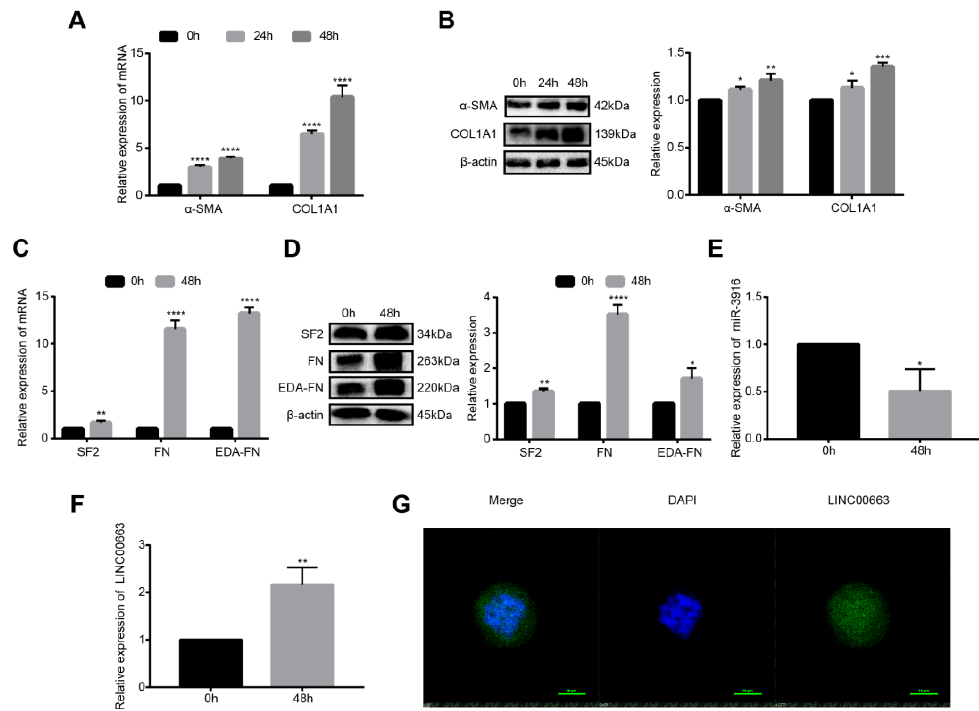
Figure 2. Validation of ceRNA network in activated LX-2 cells. Relative expression of α -SMA and COL1A1 in LX-2 cells treated with 10 ng/mL TGF- β for 24 h or 48 h detected by ( A ) RT-qPCR and ( B ) WB. Relative expression of SF2, FN and EDA-FN in LX-2 cells treated with 10 ng/mL TGF- β 1 for 48 h detected by ( C ) RT-qPCR and ( D ) WB. ( E ) Hsa-miR-3916 was downregulated in activated LX-2 cells. ( F ) LINC00663 was upregulated in activated LX-2 cells. ( G ) RNA FISH was performed to determine the location of endogenous LINC00663 (green) in LX-2 cells. Nuclei were counterstained with DAPI (blue). Scale bar = 10 µ m. * p < 0.05, ** p < 0.01, *** p < 0.001, **** p < 0.0001. Each experiment was repeated three times and similar results were obtained. ceRNA, competing endogenous RNA; COL1A1, collagen type I alpha 1 chain; EDA-FN, extra domain A of fibronectin; FISH, fluorescence in situ hybridization; FN, fibronectin; HSCs, hepatic stellate cells; RT-qPCR, real-time quantitative PCR; α -SMA, α -smooth muscle actin; SF2, splicing factor 2; TGF- β , transforming growth factor- β ; WB, western blot.